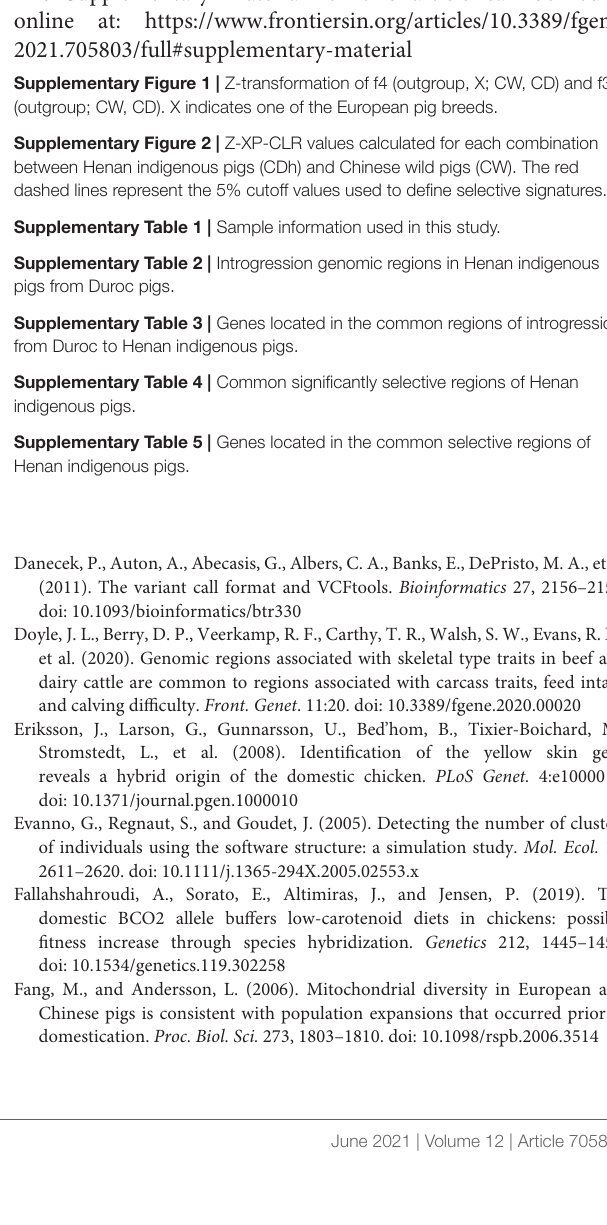
Supplementary Table 1 | Sample information used in this study. Supplementary Table 2 | Introgression genomic regions in Henan indigenous pigs from Duroc pigs.